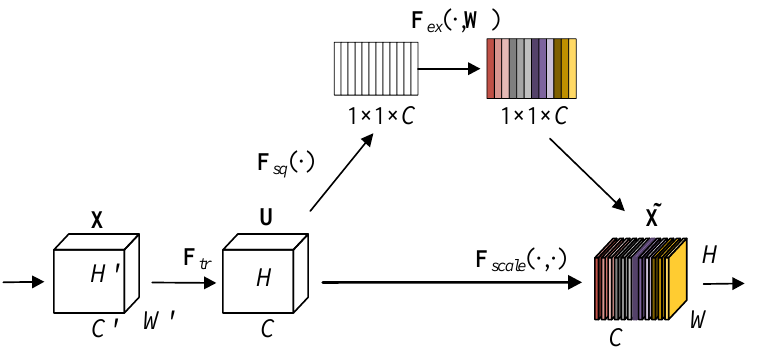
Figure 2. Architecture of SE Block.